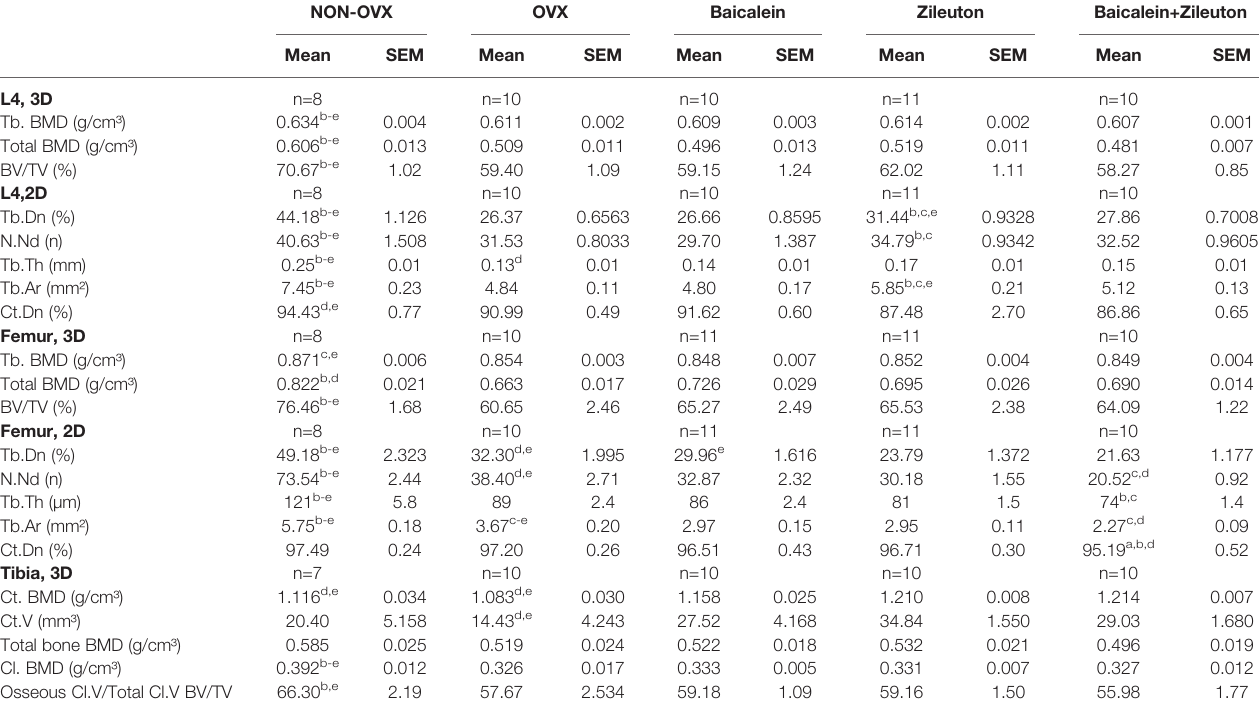
TABLE 3 | micro-CT of L4, femora and tibiae, 3D and 2D